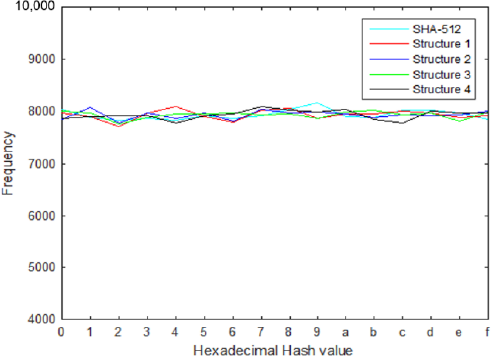
Figure 9. Hash value distribution for 1000 messages.